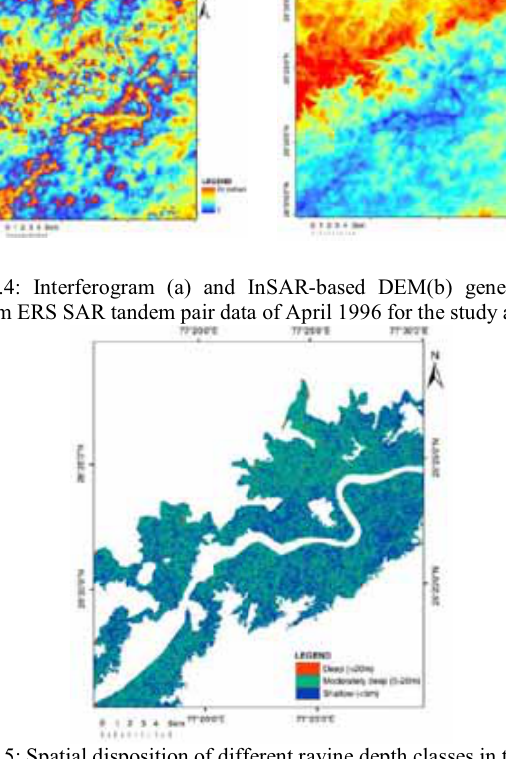
Fig.5: Spatial disposition of diff study area as obtained from the tandem pair data of